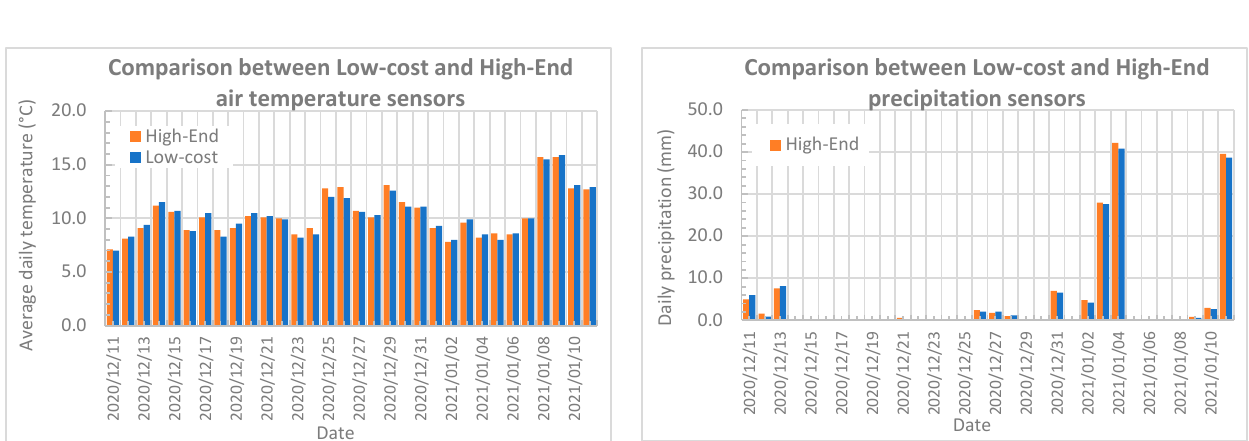
Figure 8. Comparison of the average temperatures and the total rain recorded using the low-cost and high-end weather stations. Table 2. Comparison of measurements between the low ‐ cost and high ‐ end weather stations. Differ ‐ ent letters accompanying monthly means and monthly sum values of each distinct measurement type (temperature and total rain) for each set of the industrial and low ‐ cost sensors indicate a sig ‐ nificant difference between the measurements, based on a Fisher’s least significance difference test ( p < 0.05).